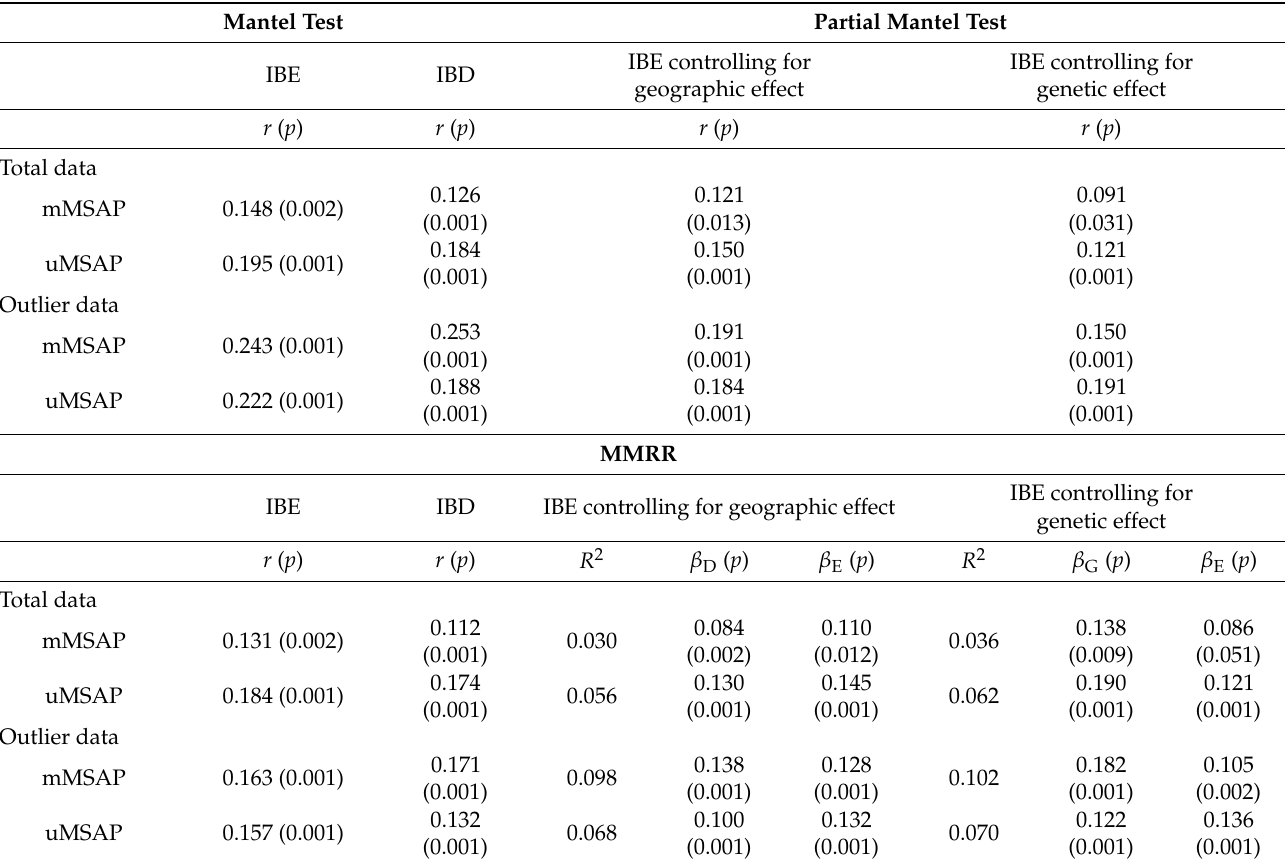
Table 5. Isolation-by-environment (IBE), isolation-by-distance (IBD), and isolation-by-genetic struc- ture (IBG) tested using the Mantel test, partial Mantel tests, and multiple matrix regression with randomization (MMRR). Euclidean distance matrices were generated based on the total and outlier mMSAP and uMSAP, AFLP, geography, and environment. The partial Mantel test and MMRR were used to infer the effects of IBE controlling for geography or genetic structure. In MMRR, R 2 represents the total amount of variation explained by both geographic and environmental factors or by both genetic structure and environmental factors. Regression coefficients for IBD ( β D ), IBG ( β G ), and IBE ( β E ) were obtained using MMRR. Mantel Test Partial Mantel Test IBE controlling